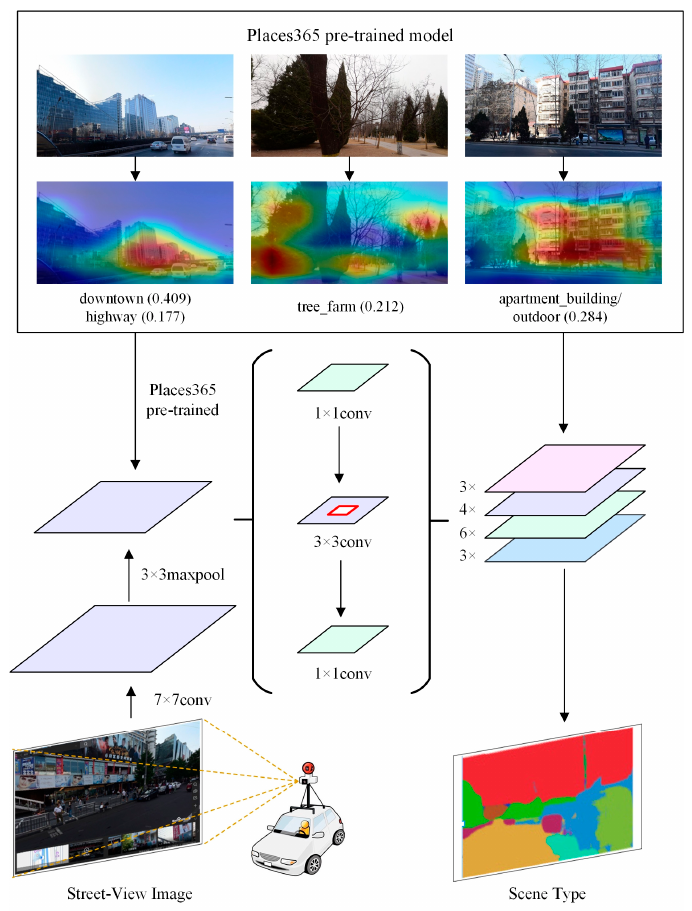
Figure 3. The ResNet-50 model architecture of 3D physical feature extraction.